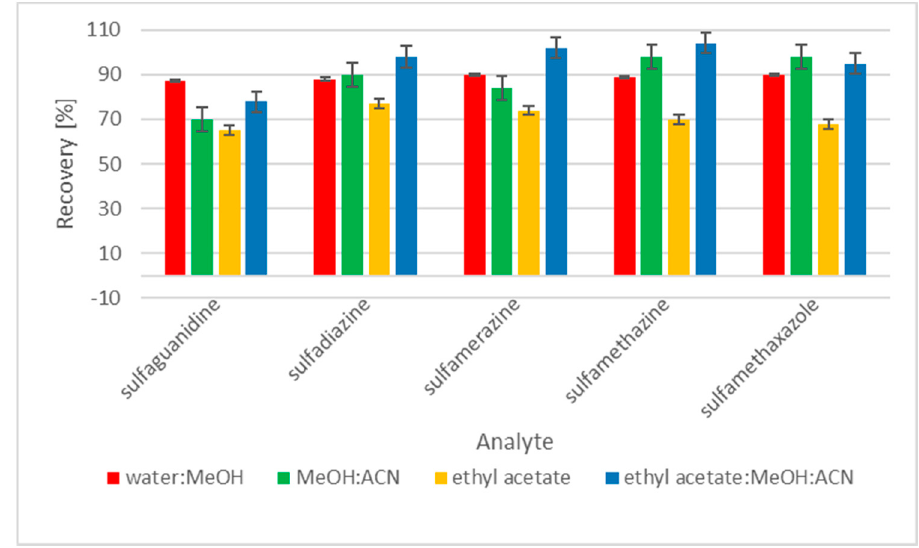
Figure 1. Recovery of sulfonamides employing different extraction solvents ( n = 6).